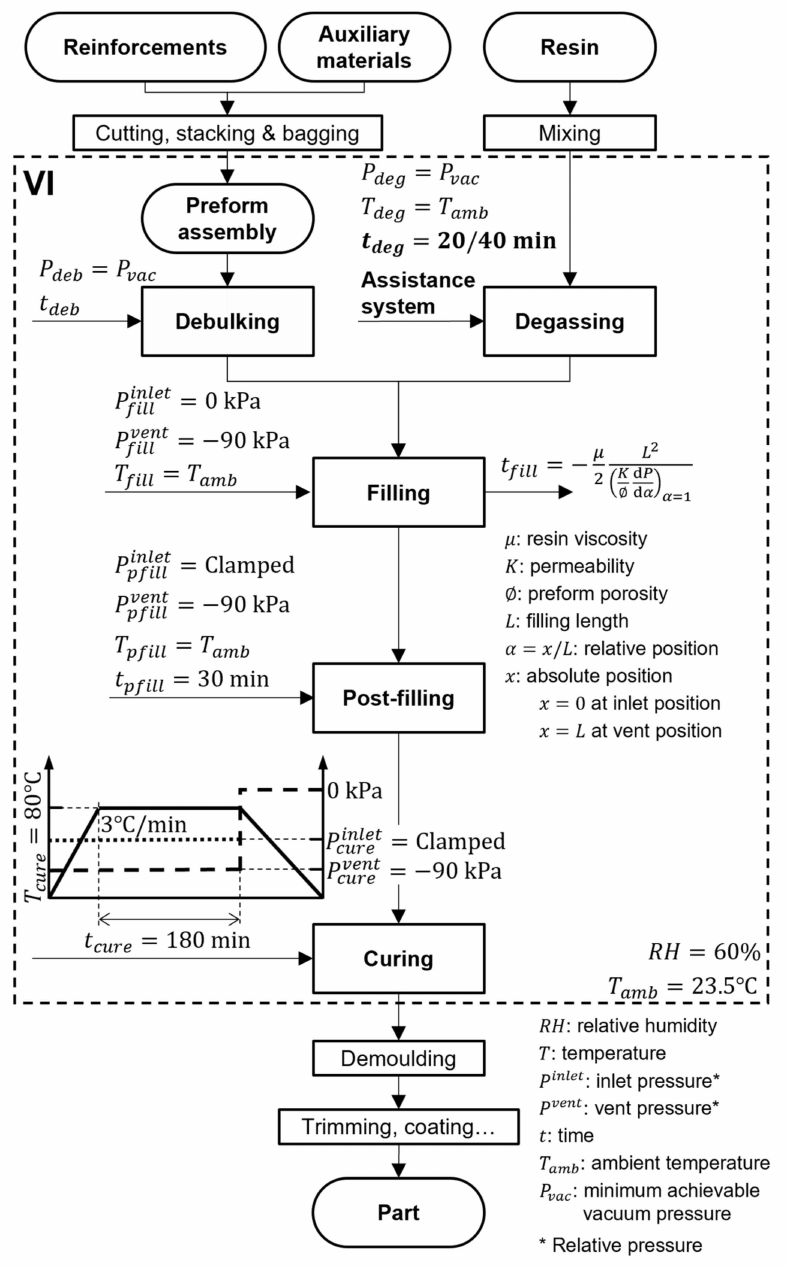
Figure 1. Flow chart and governing parameters of the VI